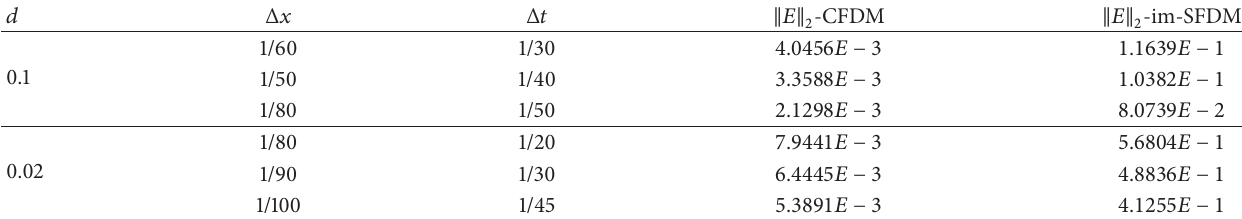
Table 3: Comparison of 𝐿 2 errors calculated by the CFDM (12) and the implicit SFDM with 𝛼 = 1.9 , different space steps Δ𝑥 and time steps Δ𝑡 at time 𝑡 = 1.5 , for two different diffusion coefficients 𝑑 = 0.1 and 𝑑 = 0.02 .